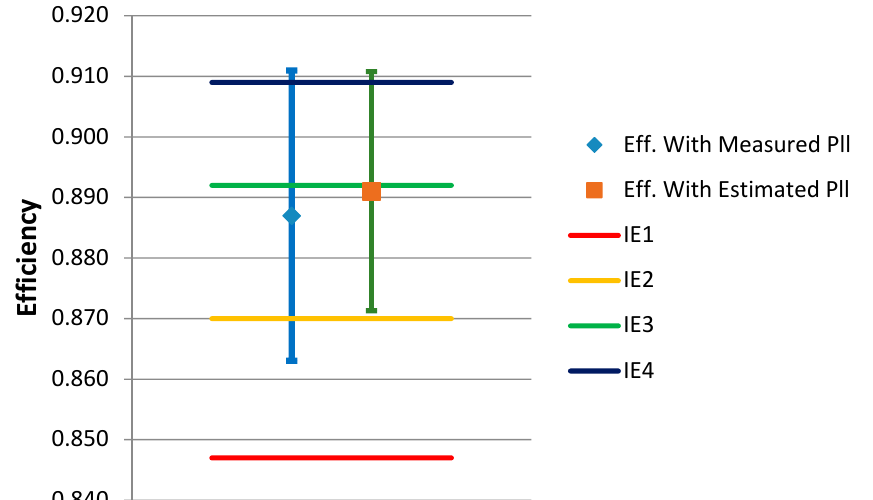
Figure 5. Comparison between the experimental efficiencies, with an extended uncertainties coverage factor of 3, and IE efficiency levels.